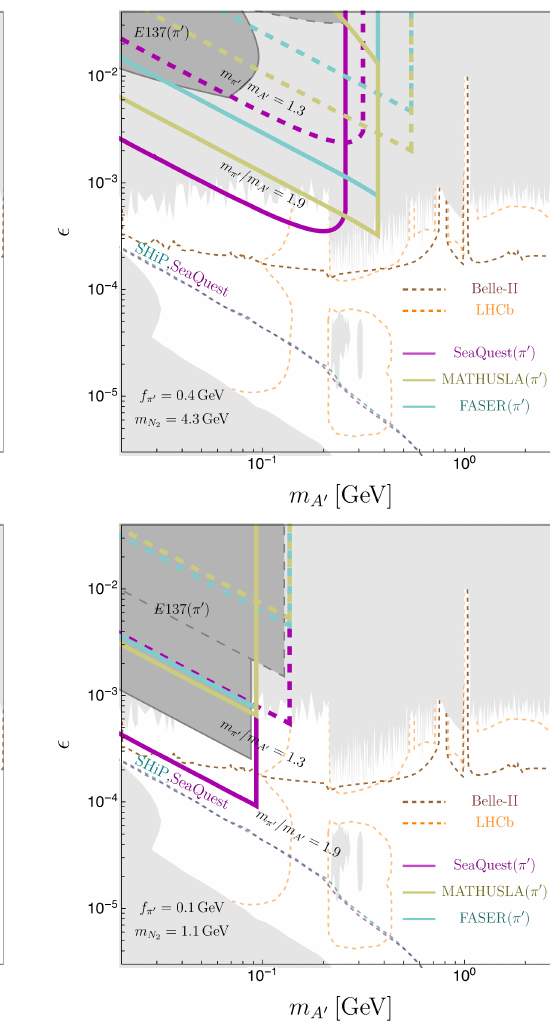
Figure 5 . Dark pion searches at fixed-target and collider experiments on (cid:15) - m A 0 plane with different values of m = 1.9 (solid) and 1.3 (dashed). We take the different choice of π 0 /m A 0 pion decay constants f : f = 0 . 8 , 0 . 4 , 0 . 2 , and 0 . 1 GeV . The future sensitivities to the π 0 π 0 three-body dark pion decay are shown by magenta lines (SeaQuest), yellow lines (MATHUSLA), and light blue lines (FASER). The dark-shaded region in the left-top of the panels is excluded by E137 experiment [12, 13]: with dashed boundary ( m = 1 . 3 ) and with solid boundary π 0 /m A 0 ( m = 1 . 9 ). The existence constraints are depicted as the shaded region on top (BaBar, π 0 /m A 0 KLOE, and LHCb) and left-bottom ( ν Cal and CHARM) in each panel, and the future sensitivities to the visible dark photon decay are shown as thin-dashed lines, Belle-II (brown), LHCb (orange), SHiP (cyan), and SeaQuest